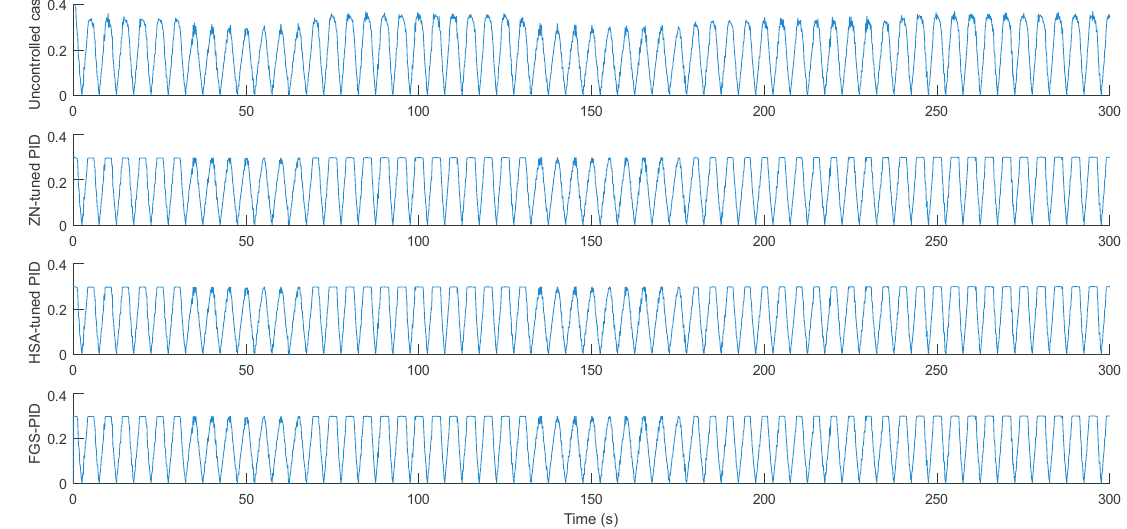
Figure 21. Flow coefficients with different control methodologies in irregular waves.